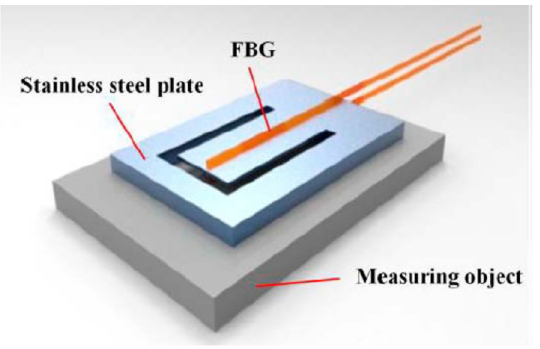
Figure 3. FBG-based finite vibration sensor used to emphasize the dynamic excitation of monitored structure [55].